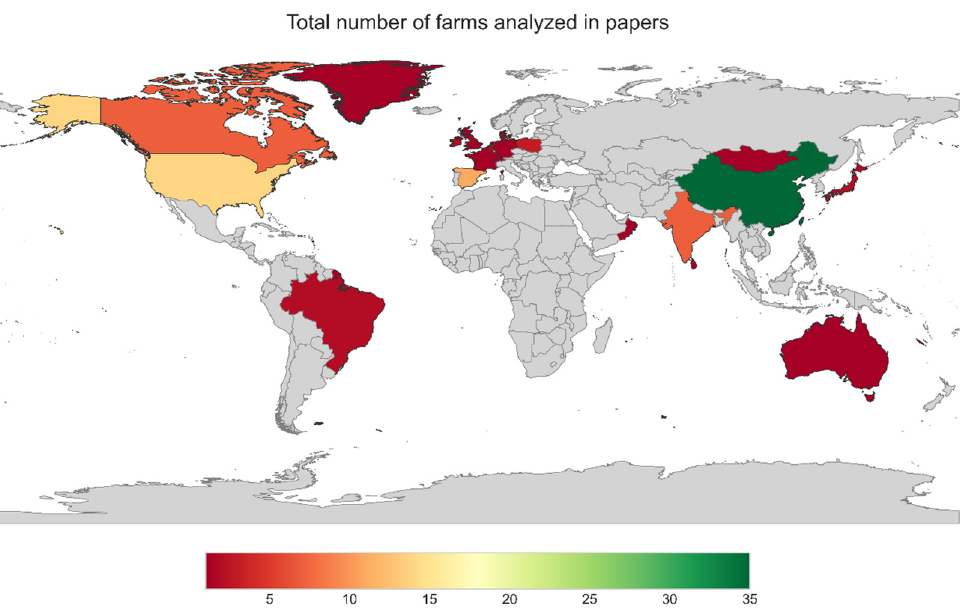
Figure 1. Total number of farms analyzed in 116 papers.